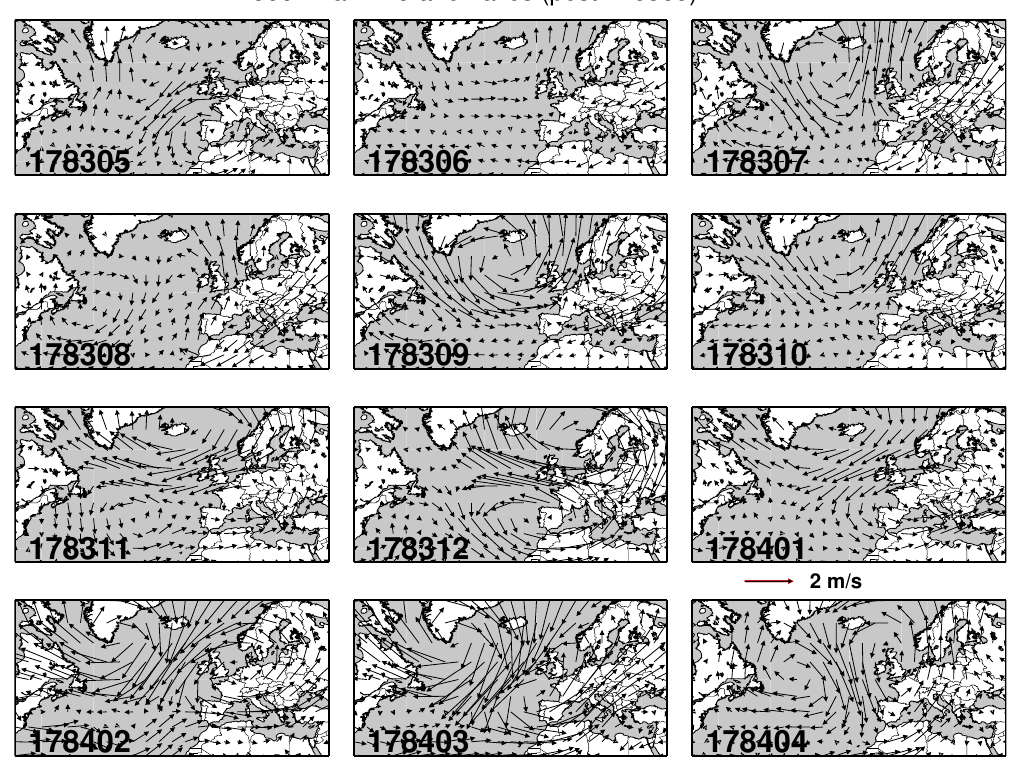
Fig. 8. Anomalies of wind speed at 500hPa between May 1783 and April 1784. The red horizontal arrow indicates the wind speed scale (in ms − 1